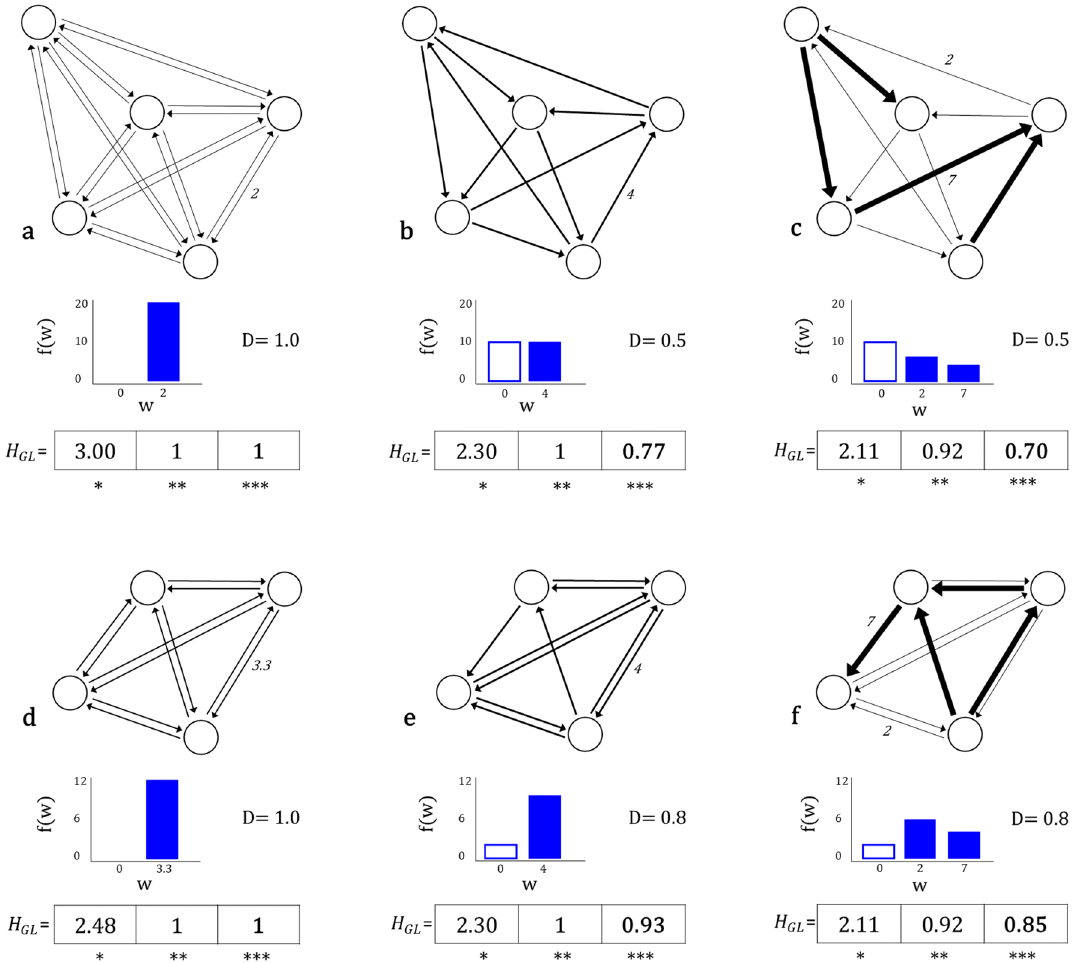
Figure 2. Global links entropy. Example of commuting networks with the distribution of link weights f ( w ), the link density D = m / n ( n − 1 ) and the corresponding general entropy with normalised values: (*) = H GL , (**) = H GL / H Tm , and (***) = H GL / H Mpm . A uniform distribution of weights and high density results in a high H GL diversity (systems a and d ), while when few links concentrate many flows, and the density is low, the system will exhibit a low H GL diversity (system c ). Only the normalisation (***) is able to differentiate between systems b) and e), and c) and f), where higher link density results in higher entropy